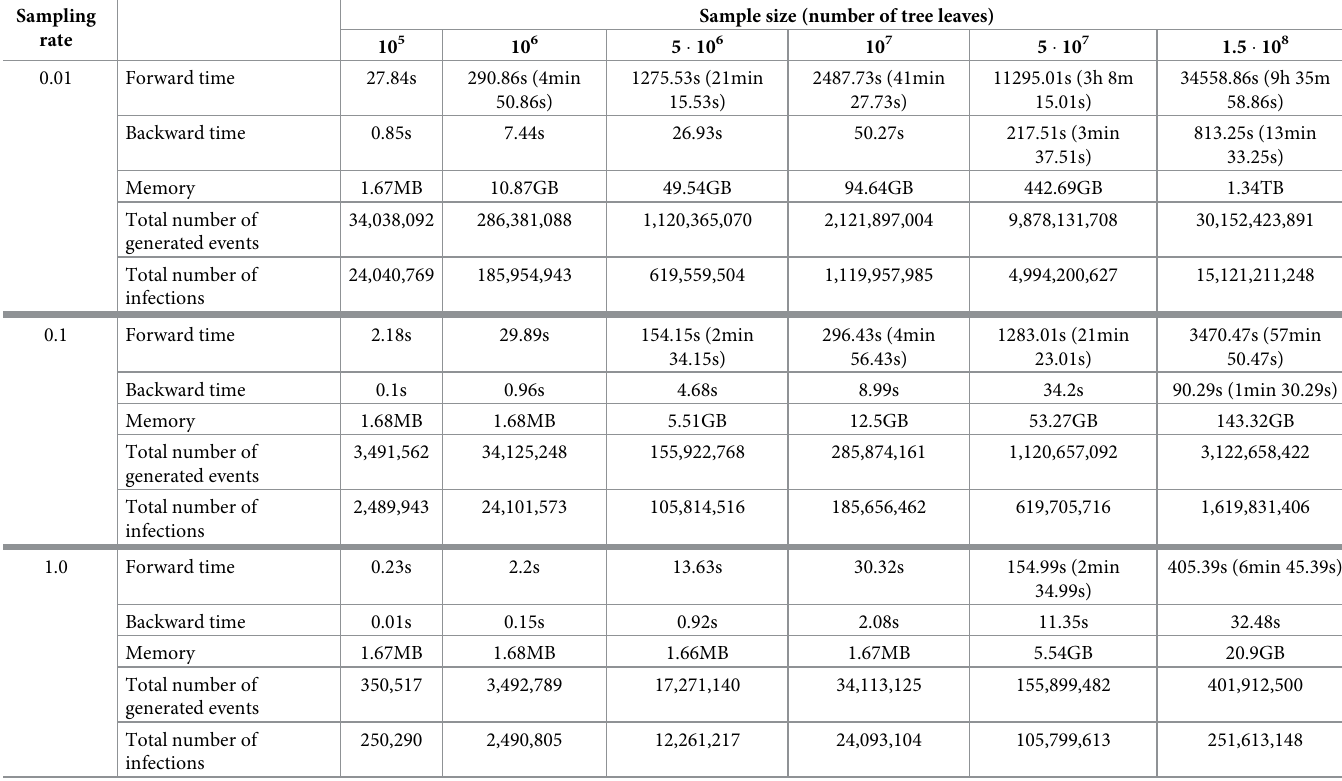
Table 4. Run time in seconds to generate a random genealogy for a sample of a certain size for different sampling rates. The execution time is shown split into the time demand for the forward run and the one for the backward run only. We simulated 16 = 4 2 haplotypes and no host immunity. The recovery rate is ρ = 1.0 − z , with z the sampling rate, while the transmission rate is λ = 2.5 for all 16 haplotypes. The tests were run on a server node with an Intel Xeon Gold 6152 2.1–3.7 GHz processor and 1536GB of memory. Sampling